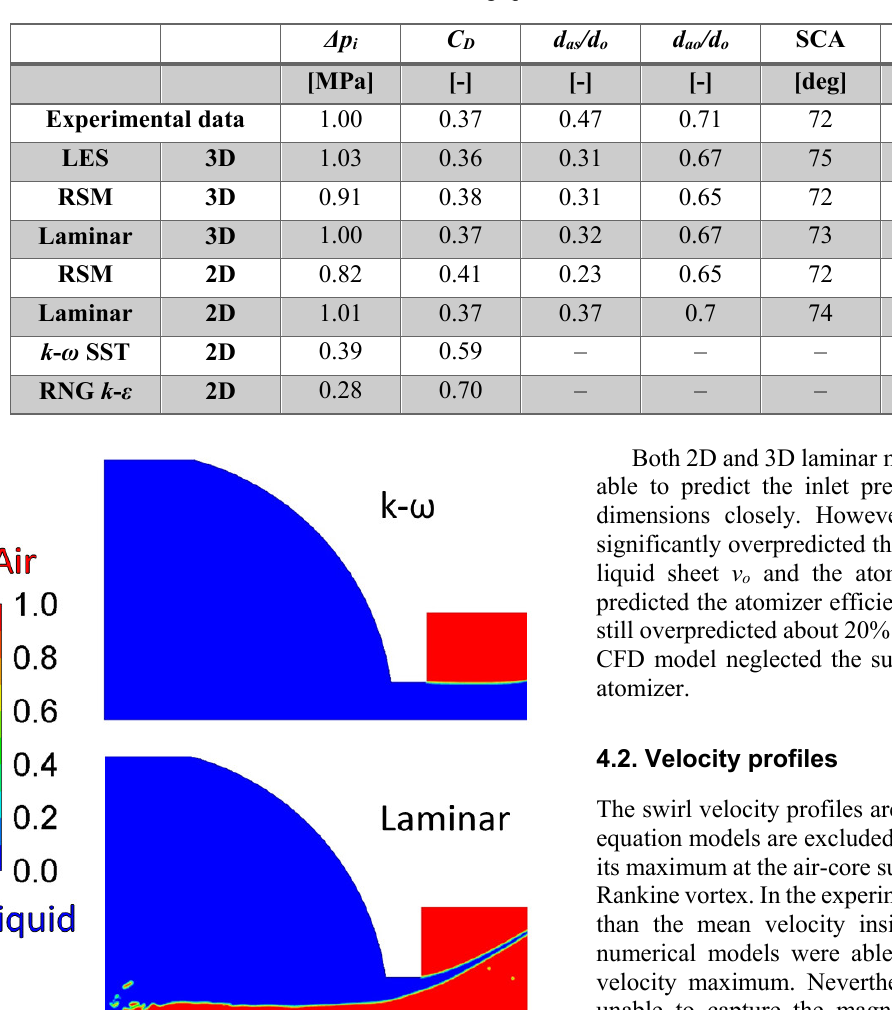
Table 1. The discharge parameters and air-core dimensions.